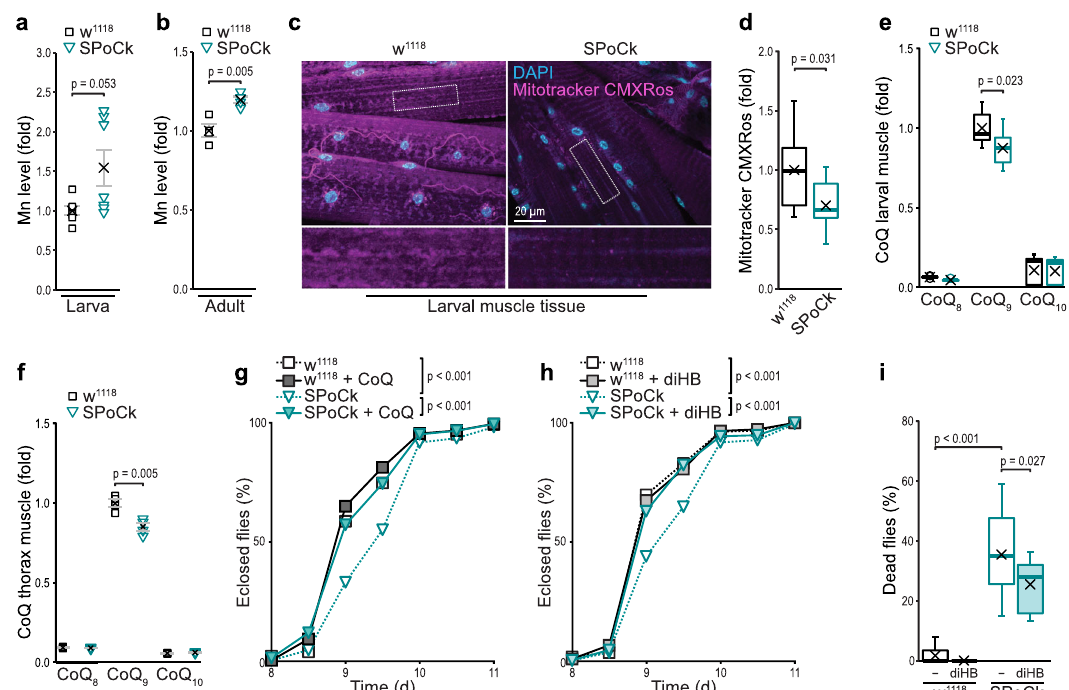
Fig. 6 | Muscle-speci fi c downregulation of SPoCk compromises CoQ biosynthesis, mitochondrial function and development in Drosophila. a , b TXRF-based determination of Mn levels in third instar larvae ( a ) and adult female fl ies 1 – 3 days after eclosion ( b ). Values have been normalized to w 1118 . n =7 (larvae) and n =4 (adults) per genotype (One n =10 larvae or fi ve fl ies). Means± SEM. c , d Confocal micrographs ( c ) and corresponding quanti fi cation of fl uores- cenceintensity( d )of w 1118 ( mef2-Gal4 >)and SPoCk-RNAi( mef2-Gal4 >UAS-SPoCk- RNAi)thirdinstarlarvalmuscletissue stainedwithMitotrackerCMXRos(magenta) to determine mitochondrial transmembrane potential. Nuclei stained with DAPI (cyan); n =10 ( w 1118 ) or 9 (SPoCk-RNAi) animals. e , f Total CoQ content determined via HPLC-ECD analysis in third instar larval muscle tissue ( e ) and thorax muscle